Question: Briefly state, in one sentence, what is plotted here.
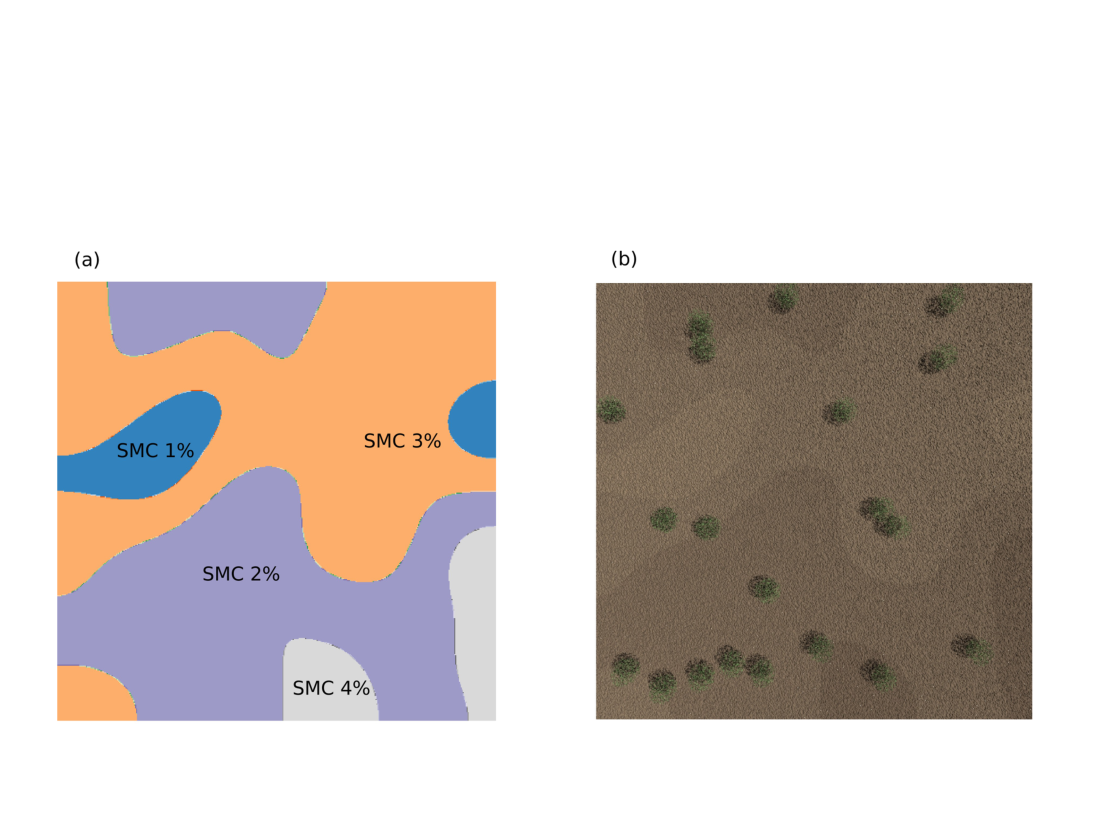
Answer: (a) Soil SMC distribution map. (b) Synthetic soil image based on soil spectra affected by corresponding SMCs.